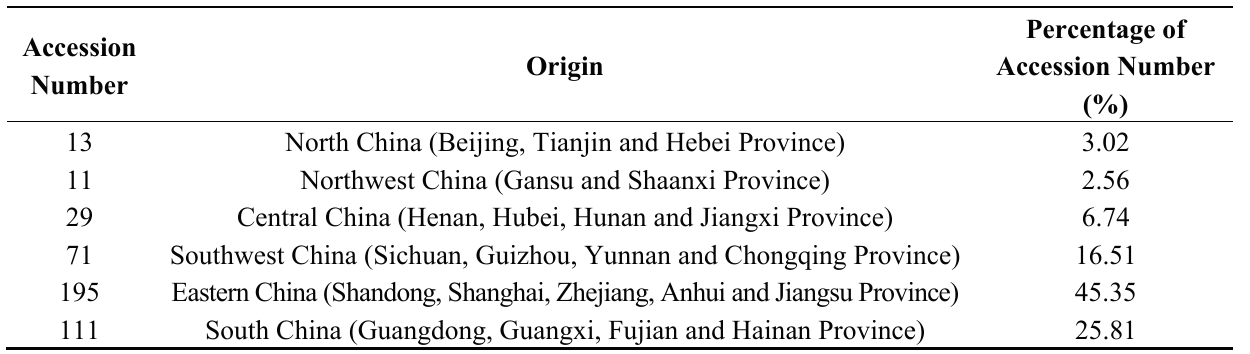
Table 2. Geographical origins of 430 C. dactylon accessions investigated in the present study.